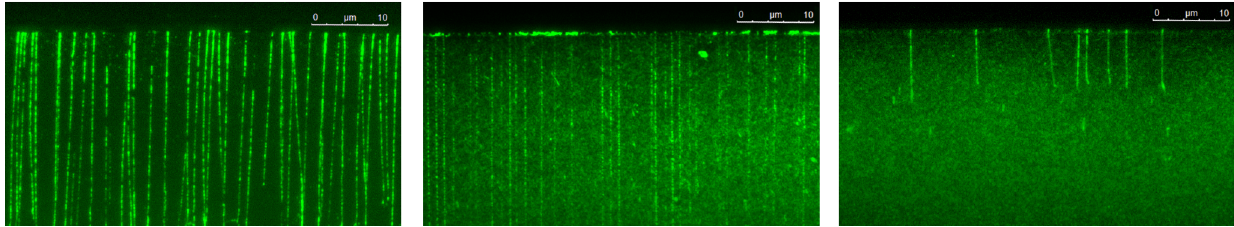
Figure 2. Threading of single and double-stranded DNA. Various DNA types are compatible with molecular threading. ( A ) Concatamers of m13mp18 ssDNA prepared by rolling-circle amplification, extracted to 40 m m. ( B ) Double-stranded genomic T4 GT7 bacteriophage DNA, extracted to 40 m m. ( C ) Double-stranded l bacteriophage DNA, extracted to 10 m m. All samples were threaded onto different elastomer substrates and stained with intercalating dye YOYO-1 prior to deposition.